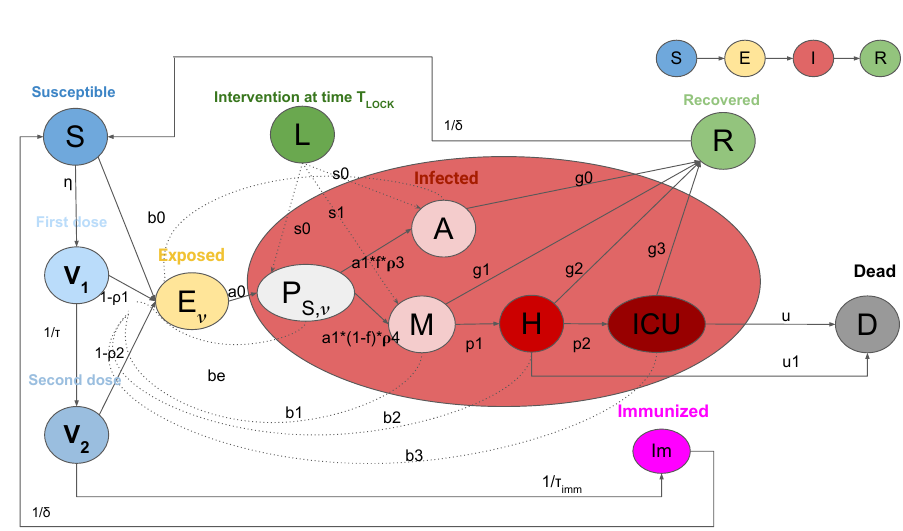
Figure 1. Graphic representation of the SEIRL-V model. Clinical stages for the population are as follows: Susceptible ( S ), Exposed ( E ν ), Presymptomatic ( P S , ν ), Asymptomatic ( A ), Recovered ( R ), Mild infection ( M ), Severe infection ( H ), Critical infection ( ICU ), Dead ( D ), Vaccinated 1st dose ( V 1 ) , Vaccinated 2nd dose ( V 2 ) , and Immunized ( Im ). The intervention measures are represented by L . Parameters b i